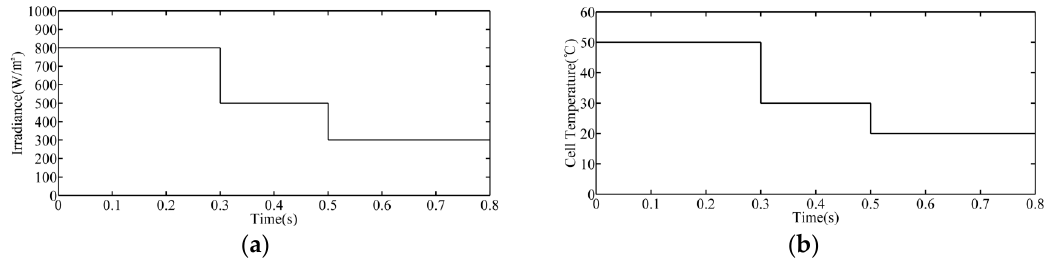
Figure 13. Fast variations of ( a ) solar irradiance and ( b ) solar cell temperature for PV arrays 2 and 3.